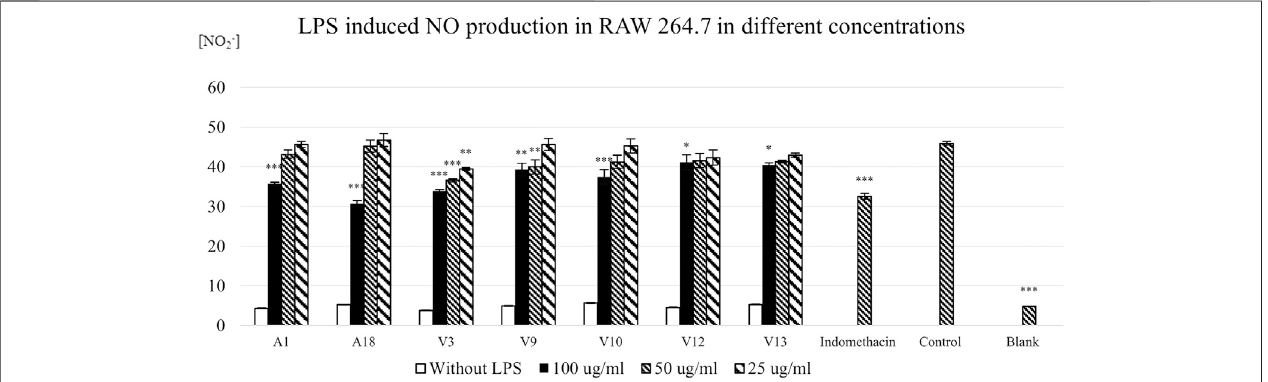
FIGURE 7 | The effect of Danshen extracts on LPS induced NO production in RAW 264.7. 200 μ l of the RAW 264.7 cells with the density of 2.5 × 10 5 cells/ μ l is treatedwith100,50,and25 μ g/mlofsamplefor24 h.20 μ g/mlofindomethacinisusedasthepositivecontrol.Theresultsofthesamplesthatshowsigni fi cantinhibition on LPS induced NO production on the RAW 264.7. 0.05% DMSO was used as the control of the experiment. The NO concentration is based on the standard curve of